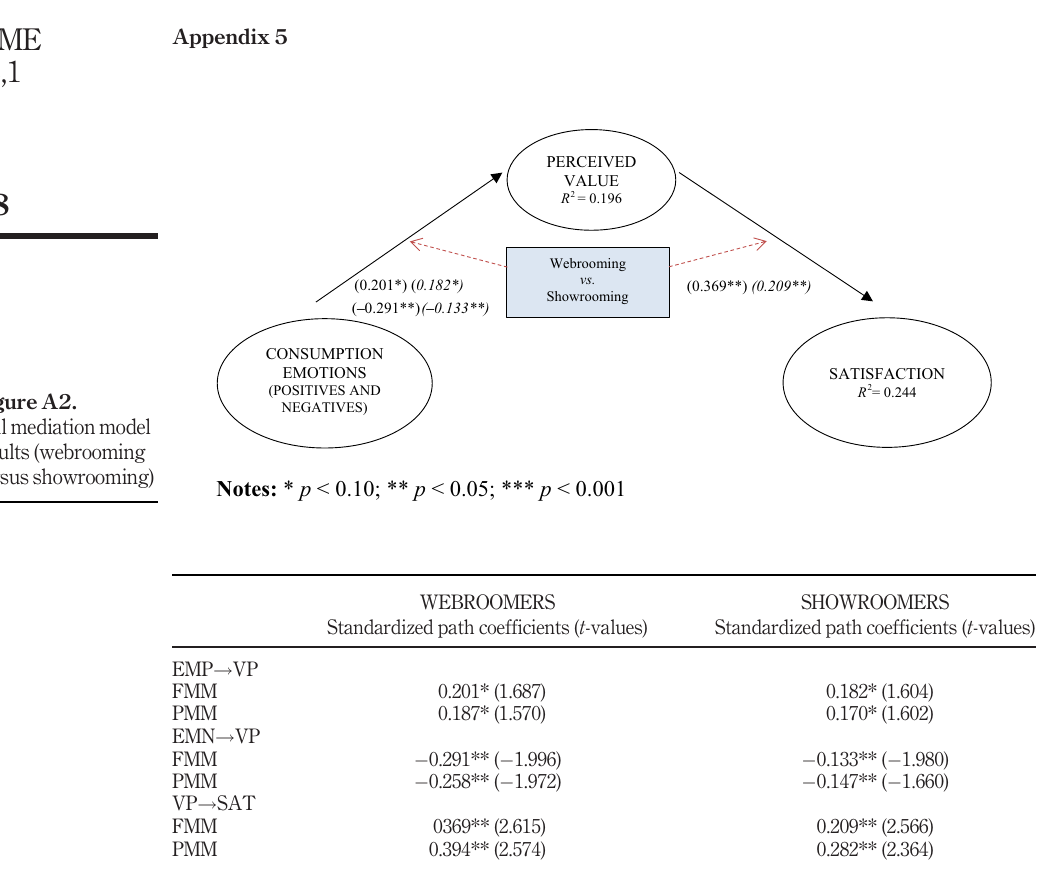
Table AXI. Results of SEM for full mediation and partial mediation models of